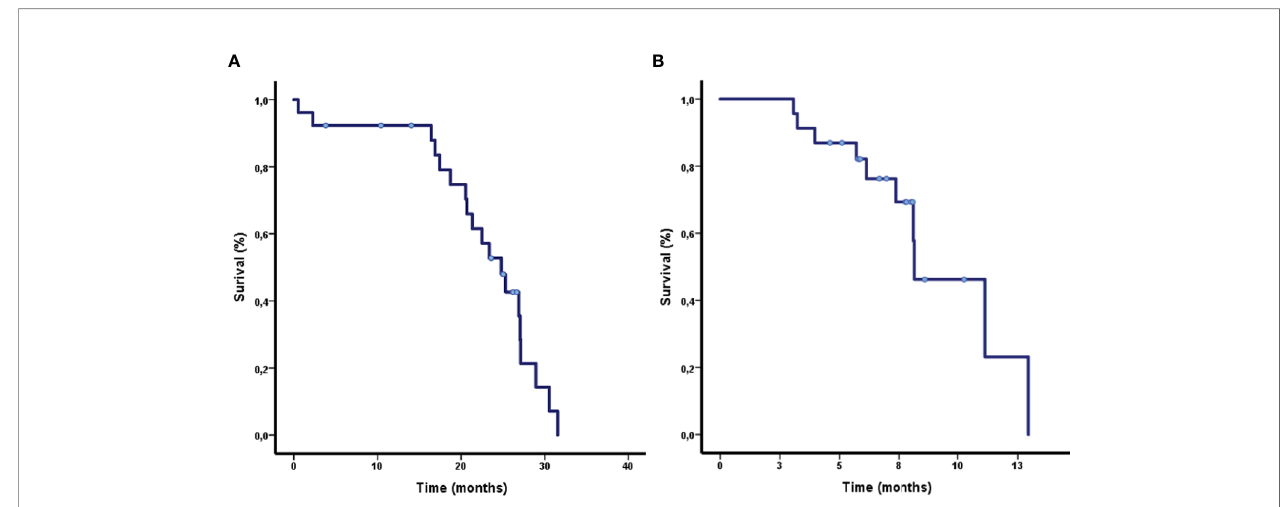
FIGURE 3 | (A, B) Overall survival and progression free survival for fi rst line treatment in patients included in the study.